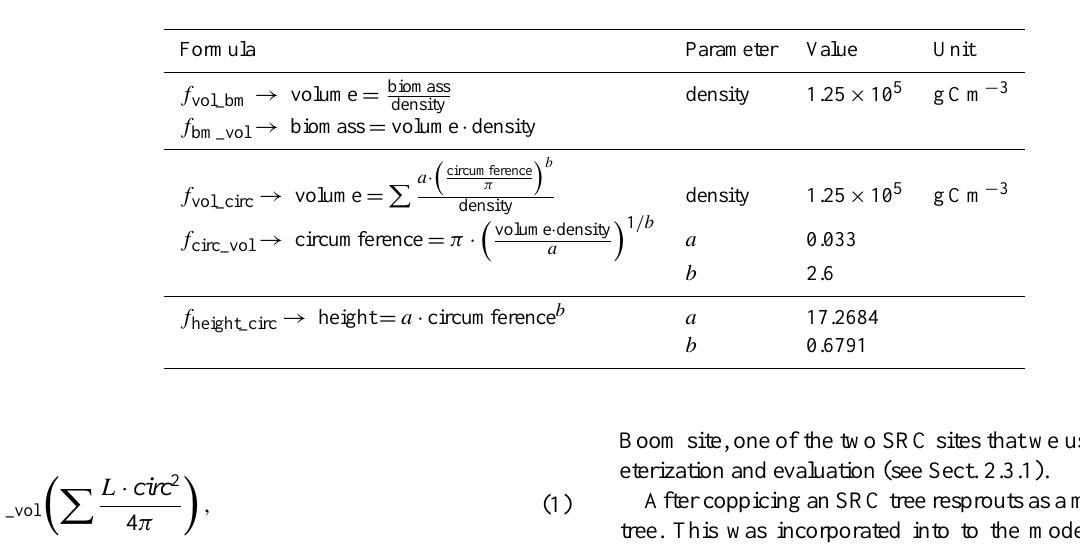
Table 1. Allometric relations used for the SRC simulation in the ORCHIDEE-FM model and their parameter values. SRC indicates short rotation coppice